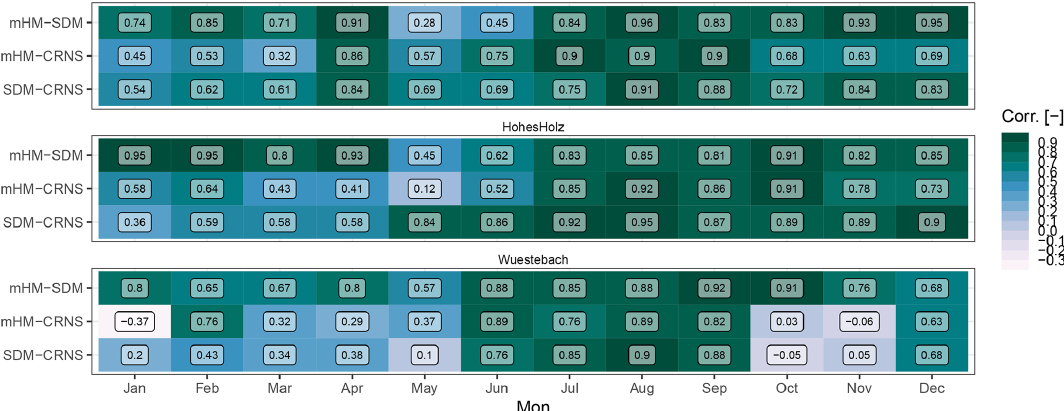
Hydrol. Earth Syst. Sci., 26, 5137–5161, 2022